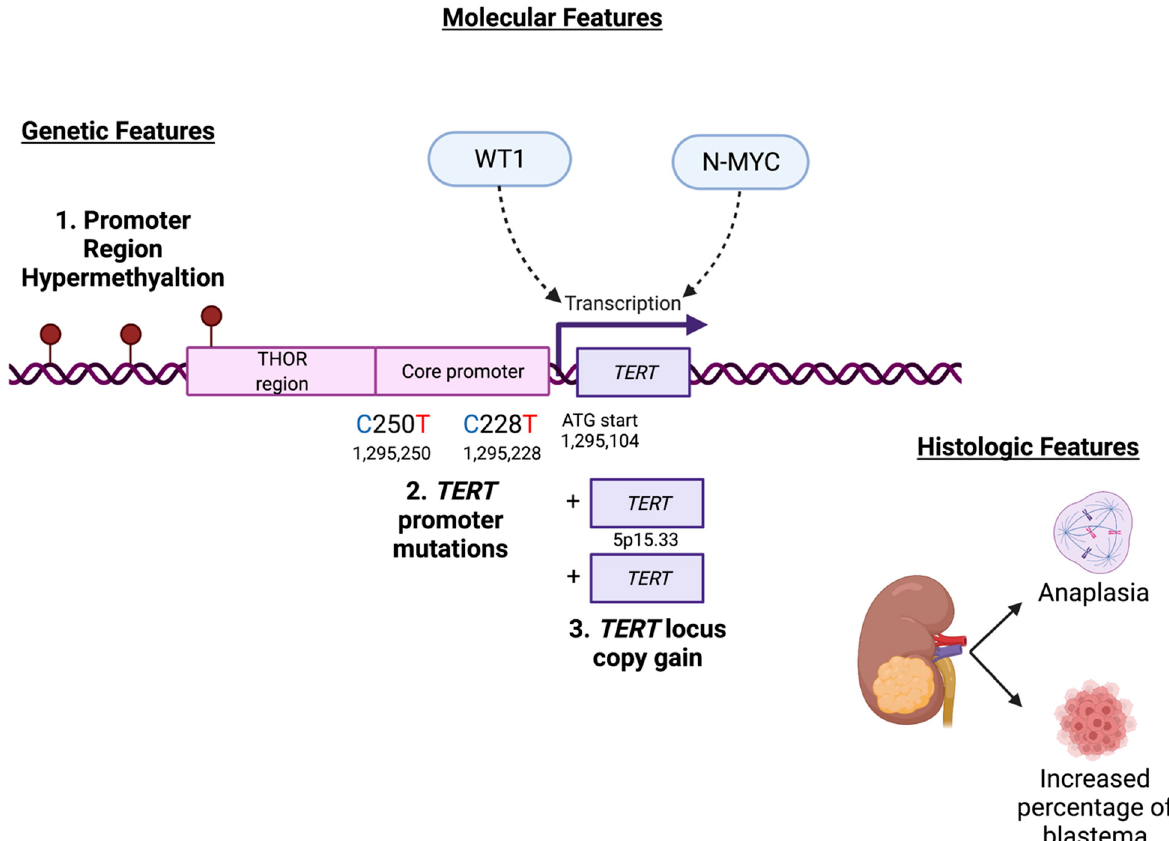
Figure 7. Summary of genetic, molecular, and histologic findings associated with TERT in Wilms tumor. Graphic created with BioRender.com.